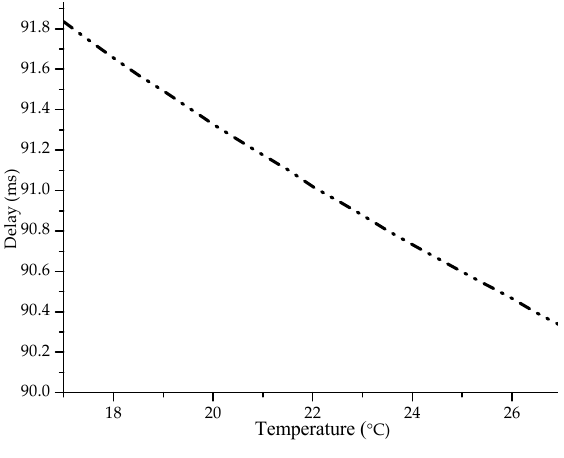
Figure 8. Delay versus Temperature.